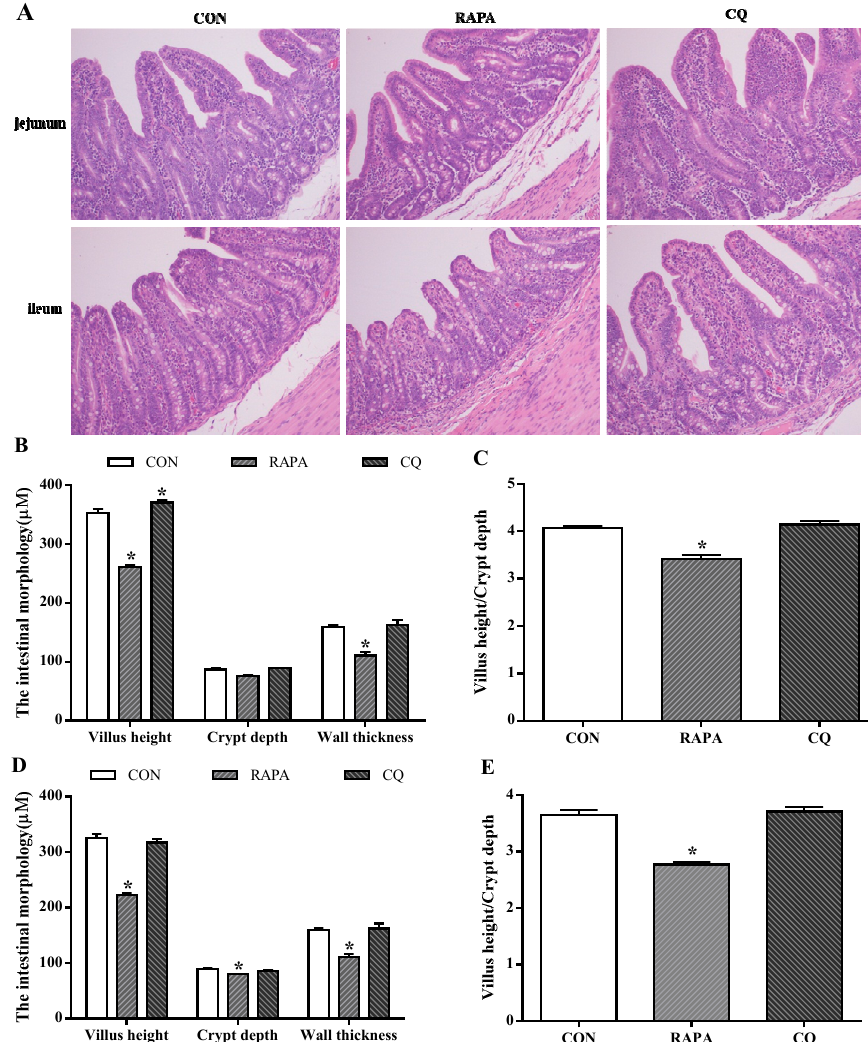
Figure 2. Morphology analysis. ( A ) Sections were stained with hematoxylin and eosin (H and E). ( B ) Jejunum morphology. ( C ) Ratio of villus height to crypt depth in jejunum. ( D ) Ileum morphology. ( E ) Ratio of villus height to crypt depth in ileum. Dietary treatment: RAPA, rapamycin; CQ, chloroquine; CON, normal saline. Data are expressed as means ± SEM ( n = 6), all values are expressed in relation to the control. * p < 0.05 vs. control.